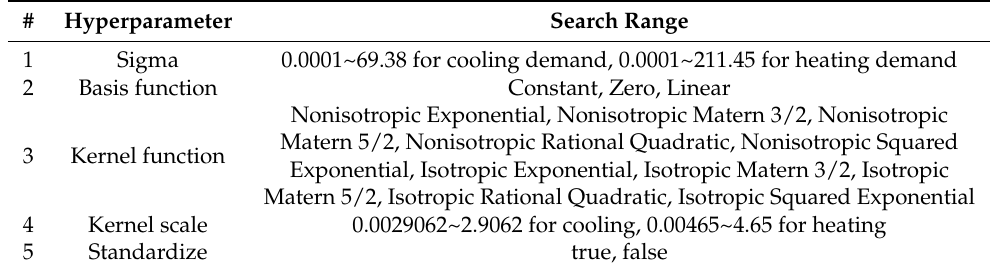
Table 4. Hyperparameter search range of optimizable GPR model training.